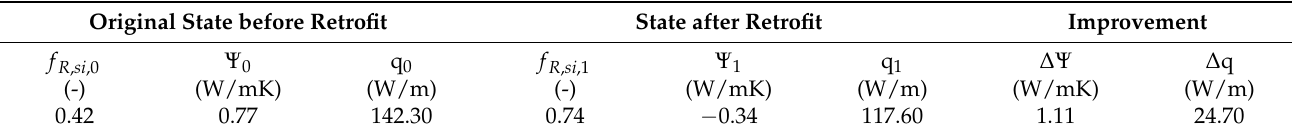
Figure A16. Before and after the thermal bridge retrofit of a window lintel (created with ThermCad thermal bridge sim- ulation calculator). Table A18. Retrofit components and costs of the thermal bridge retrofit of a window lintel [38,39]. Pos. No. Table A19. Quantifiable results of the thermal bridge retrofit of a window lintel (ThermCad thermal bridge simulation calculation). Original State before